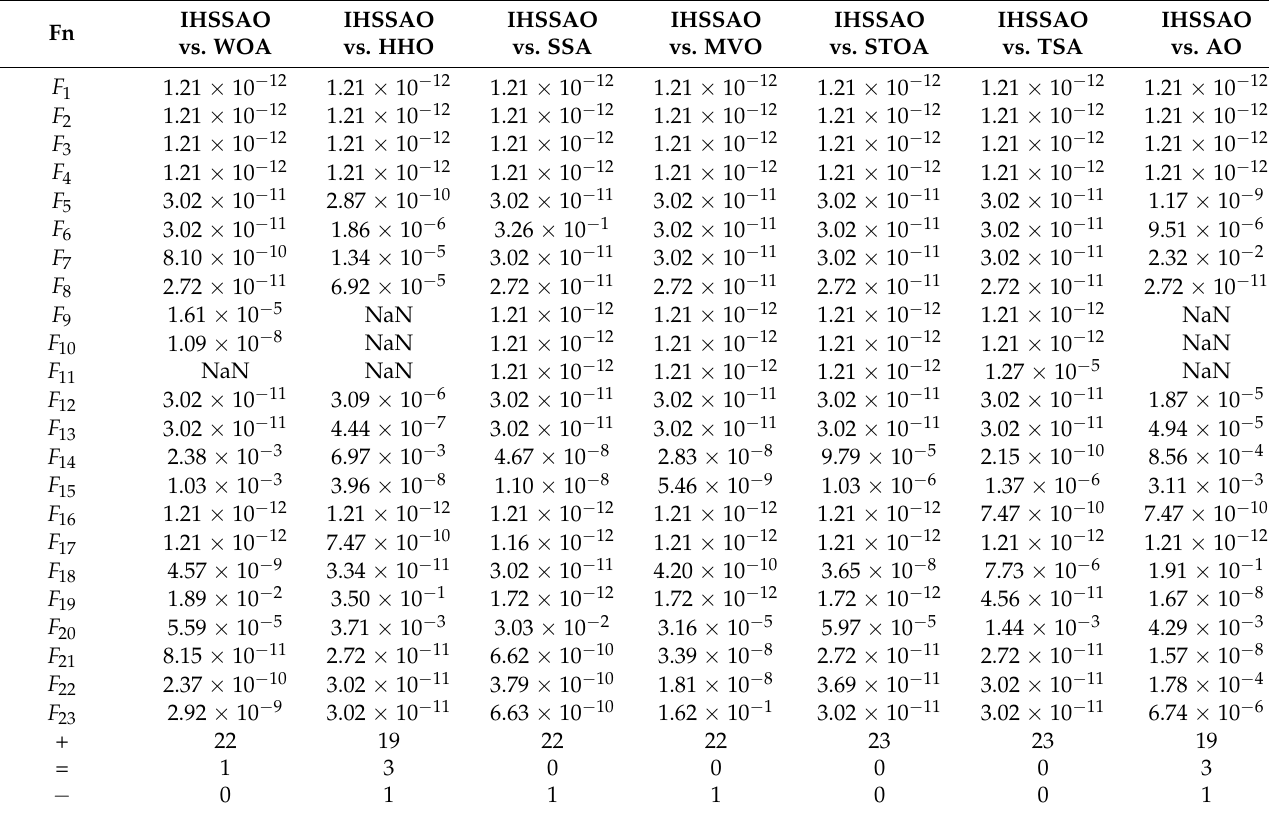
Table 6. Statistical results of IHSSAO using the Wilcoxon rank-sum test.